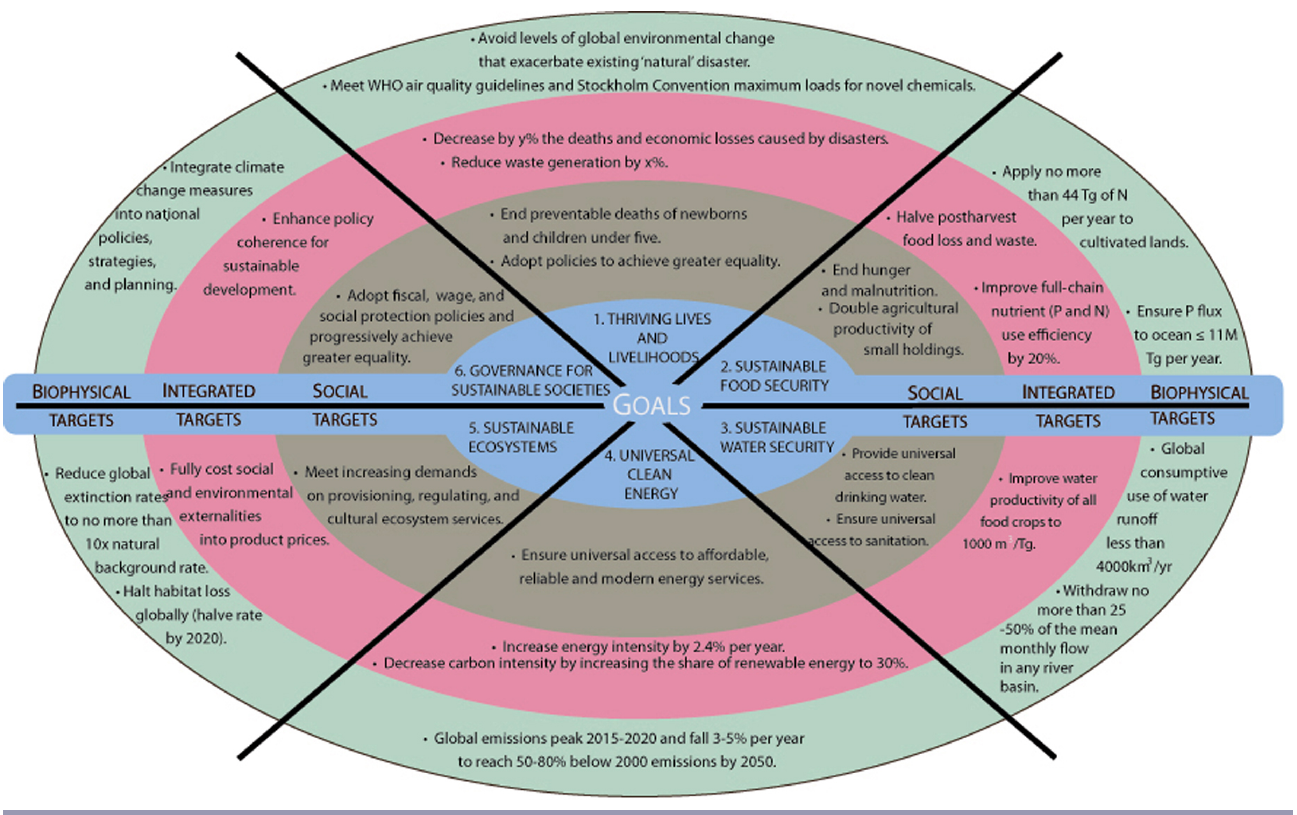
Fig. 2 . Selected examples of targets for the six proposed SDGs (centre, see Table A1), emphasizing those that are important to meeting the Global Sustainability Objectives (Table A2), including biophysical only (outer green ring), socioeconomic only (inner brown ring), and integrated (intermediate pink ring) targets. This figure contains a subset of a larger suite of possible targets shown in Table A3, with a focus on illustrating the need for some integrated